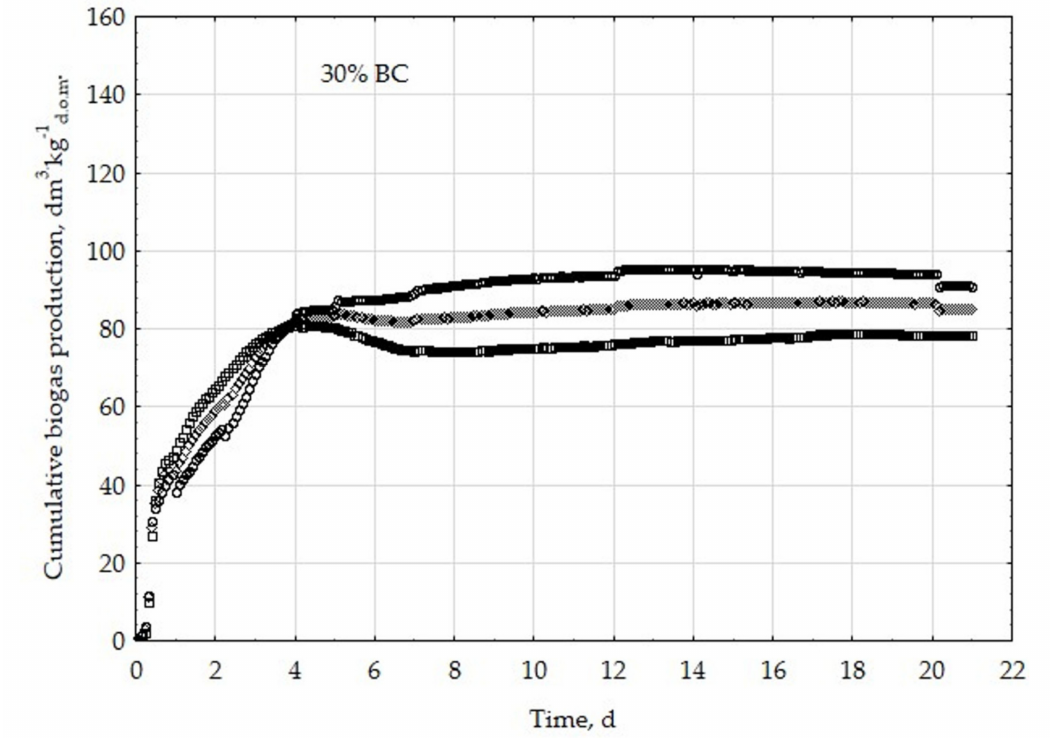
Figure A8. Biogas production from BSG: cumulative curves in variant with biochar addition at the level of 30%. The number of repetitions was